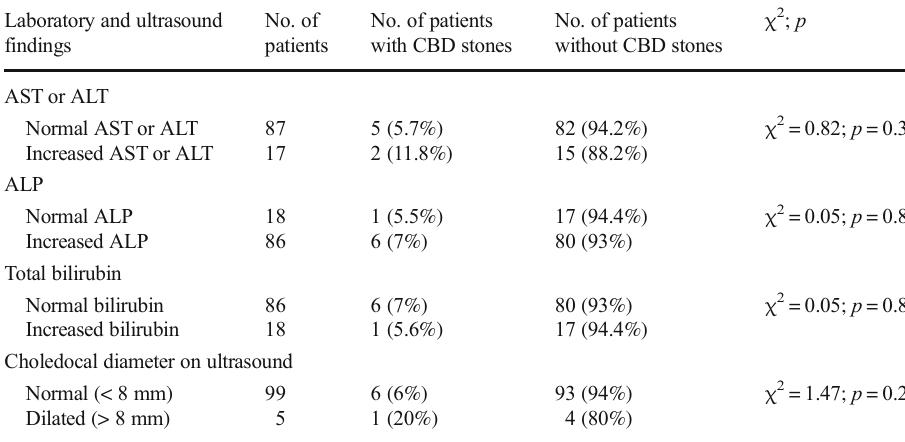
Table 2 Frequency of common bile duct (CBD) stones and relation with laboratory findings and choledocal diameter on preoperative ultrasound(US), chi- square ( χ 2 ) and p -value ( p )